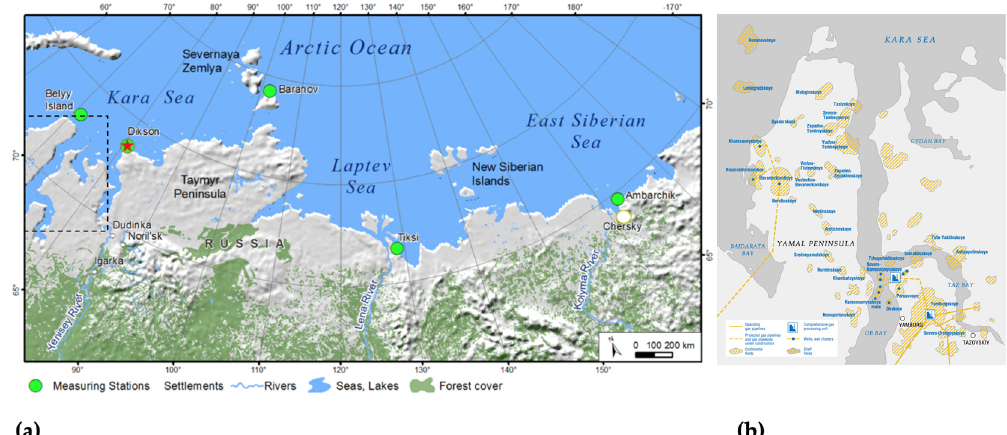
Figure 1. Network of stations continuously measuring atmospheric CO 2 and CH 4 mole fractions across the arctic domain of Siberia ( a ) with a dashed domain that outlines possible source region of the pollution anomalies for the measurement site; an overview of the polluted domain with a gas field pre-development scheme for the Ob and the Taz Bays and the Yamal Peninsula taken from the Gazprom web portal (https://www.gazprom.com/f/posts/25/697739/book_my_eng_1.pdf (accessed on 11 July 2022)) ( b ).